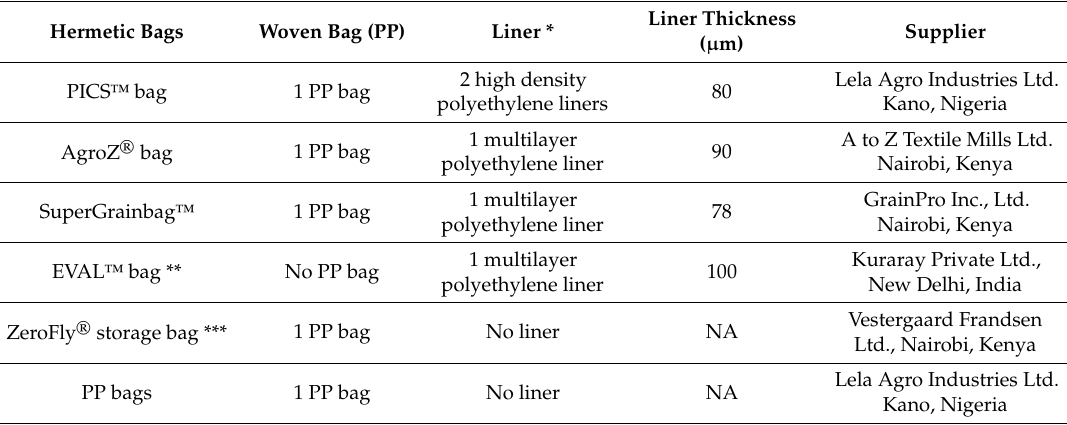
Table 1. Characteristics of six storage bags tested during this experiment in Parakou Benin. Hermetic Bags Woven Bag